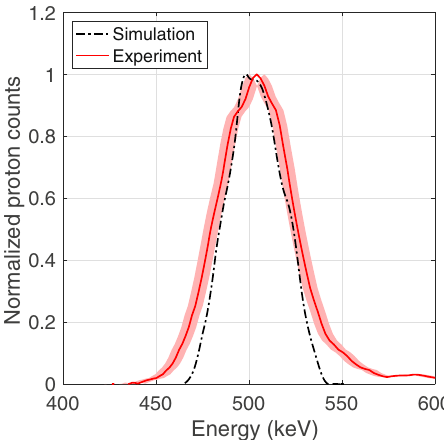
Fig. 7 Selected proton beam spectrum. Comparison between the measured selected proton beam spectrum (red solid curve) and the selected proton beam spectrum obtained from an initial broadband TNSA- like spectrum with energies of 0 – 2 MeV simulated with the FLUKA Monte-Carlo code using the experimental con fi guration for the proton energy selector (black dashed curve). The shaded area around the red curve represents the measurement